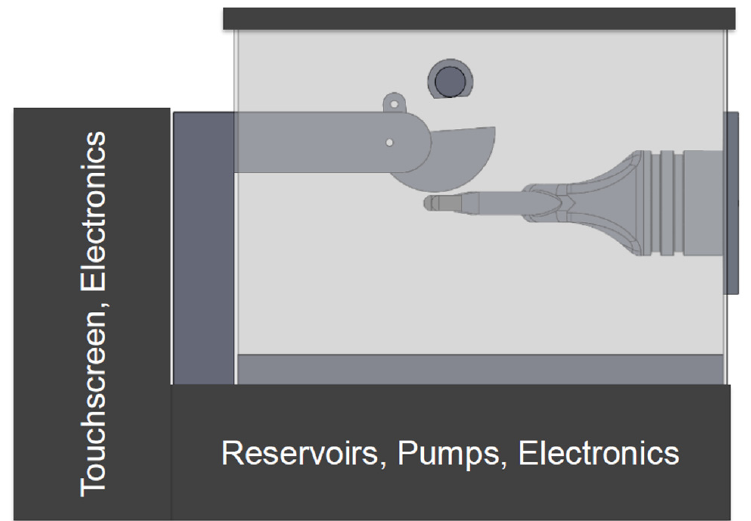
Figure 8. Conceptual AutoCAD model of the new glove testing device.